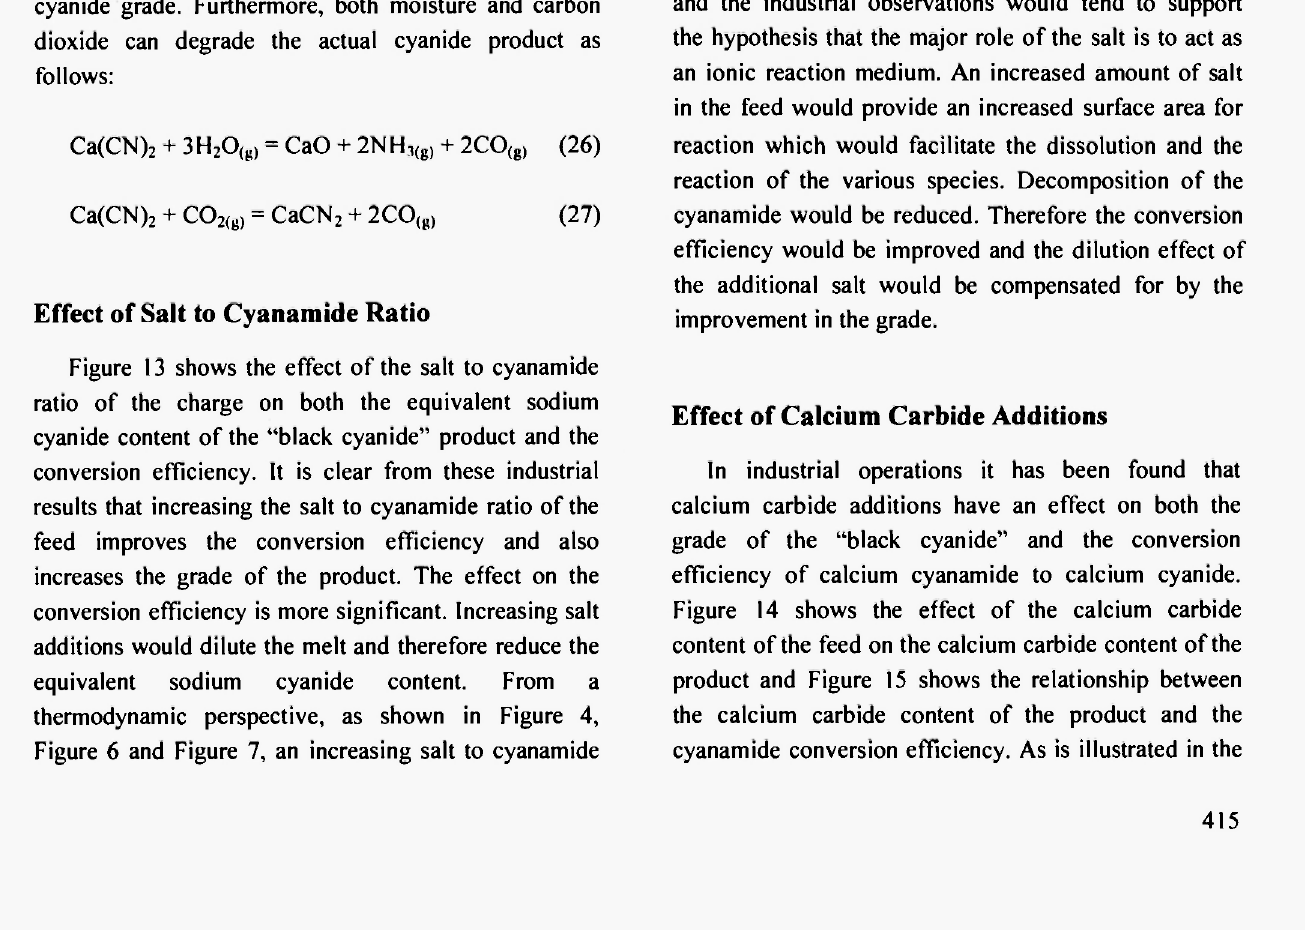
Fig. 13: Conversion efficiency and equivalent sodium cyanide content as a function of the salt to cyanamide ratio for an industrial "black cyanide"